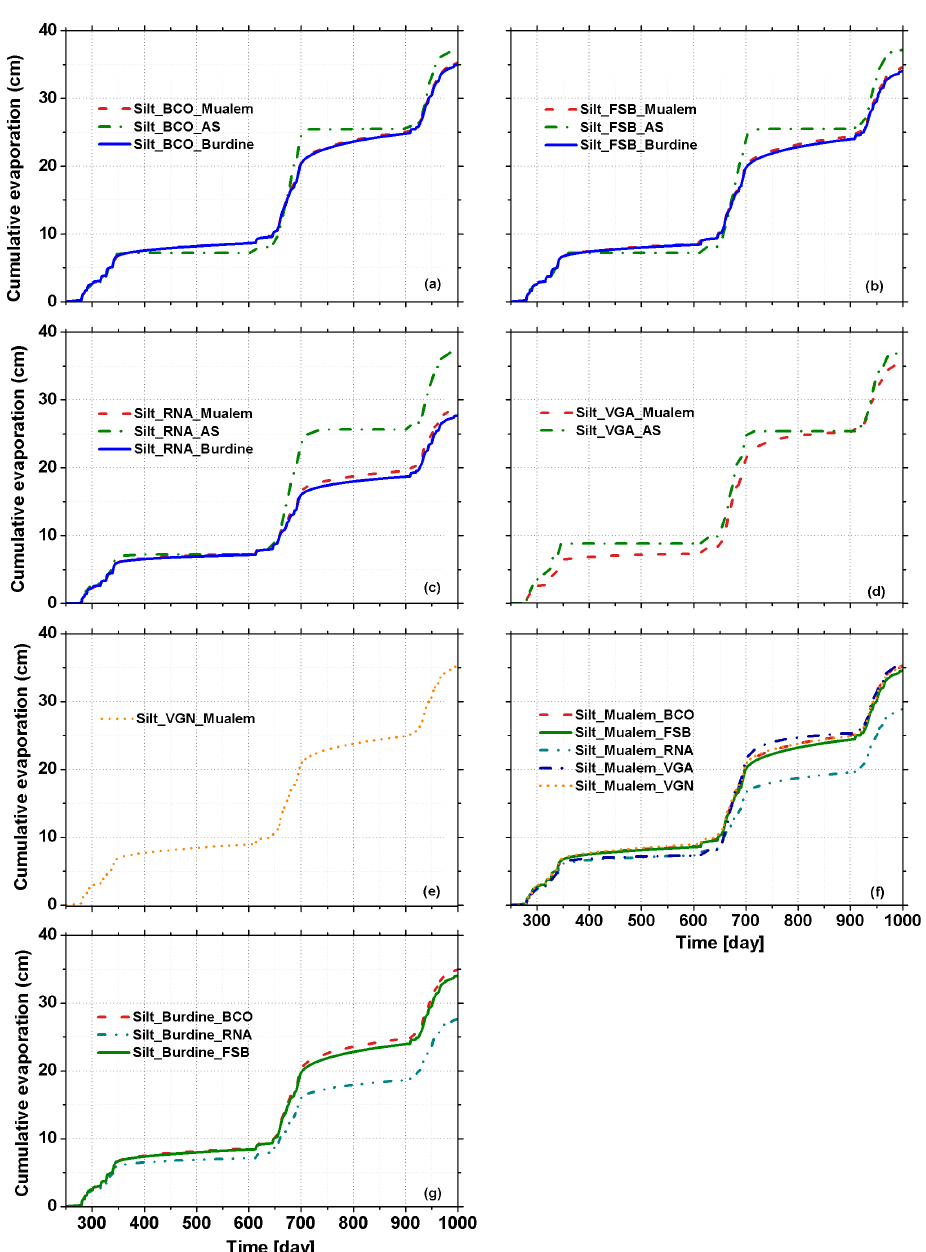
Figure 6. Cumulative evaporation from a silt soil column for the different combinations of soil water retention and hydraulic conductivity parameterizations. Panels (a) through (e) present the results for the indicated retention parameterizations (see Table 1). Panels (f, g) organize the results according to the conductivity function: either Mualem (1976) (f) or Burdine (1953) (g)